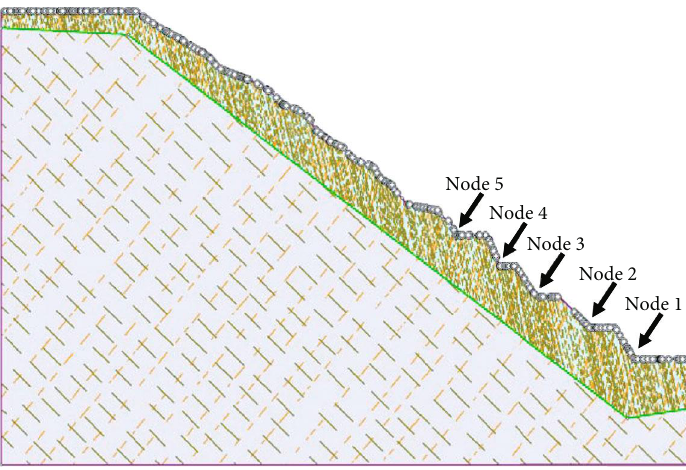
Figure 12: Contour map of Beizhan iron mine and slope calculation model.